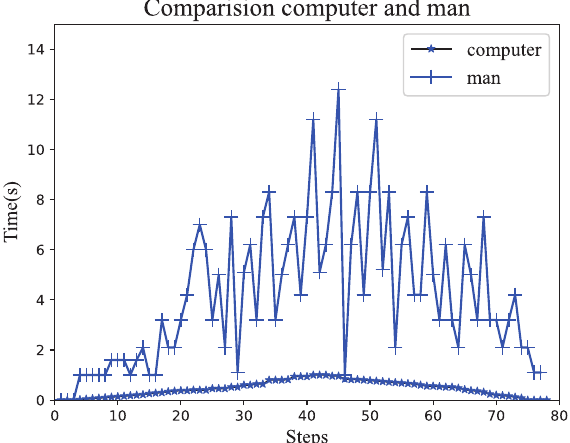
Figure 5. Comparison of reaction time between humans and